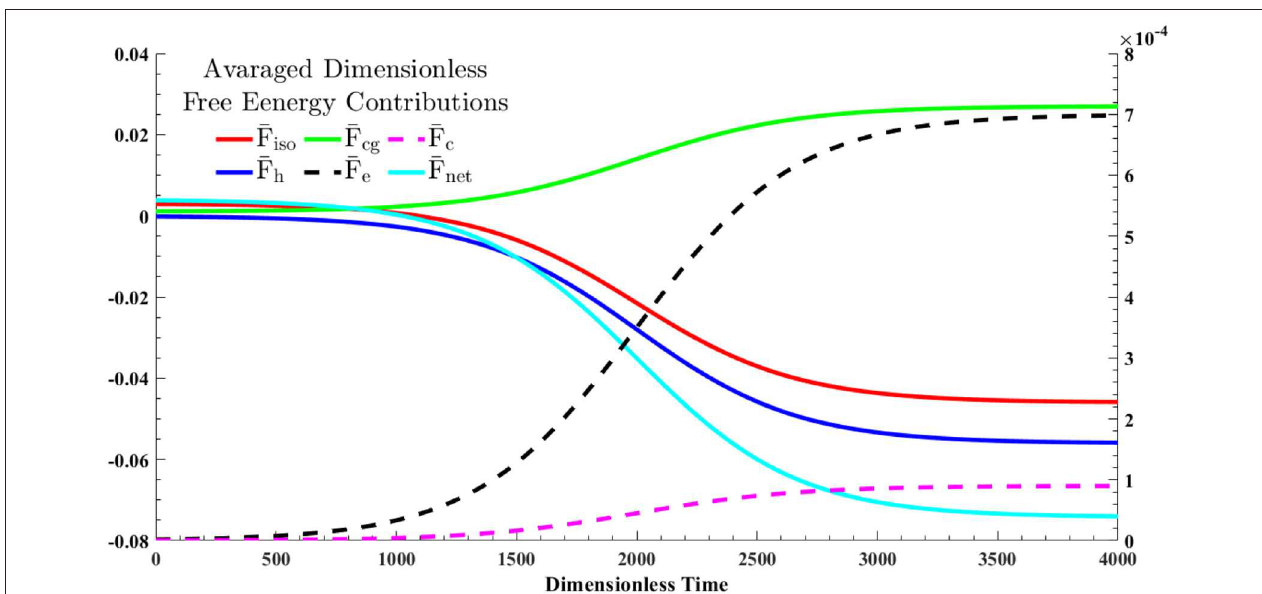
FIGURE 5 | The dynamics of the averaged free energy contributions, given in Equation (28), through a shallow quench from an isotropic state into cholesteric phase—the quench point and evolution path are shown in Figure 1 . The solid lines correspond to the left y-axis and dash lines should be referred to the right